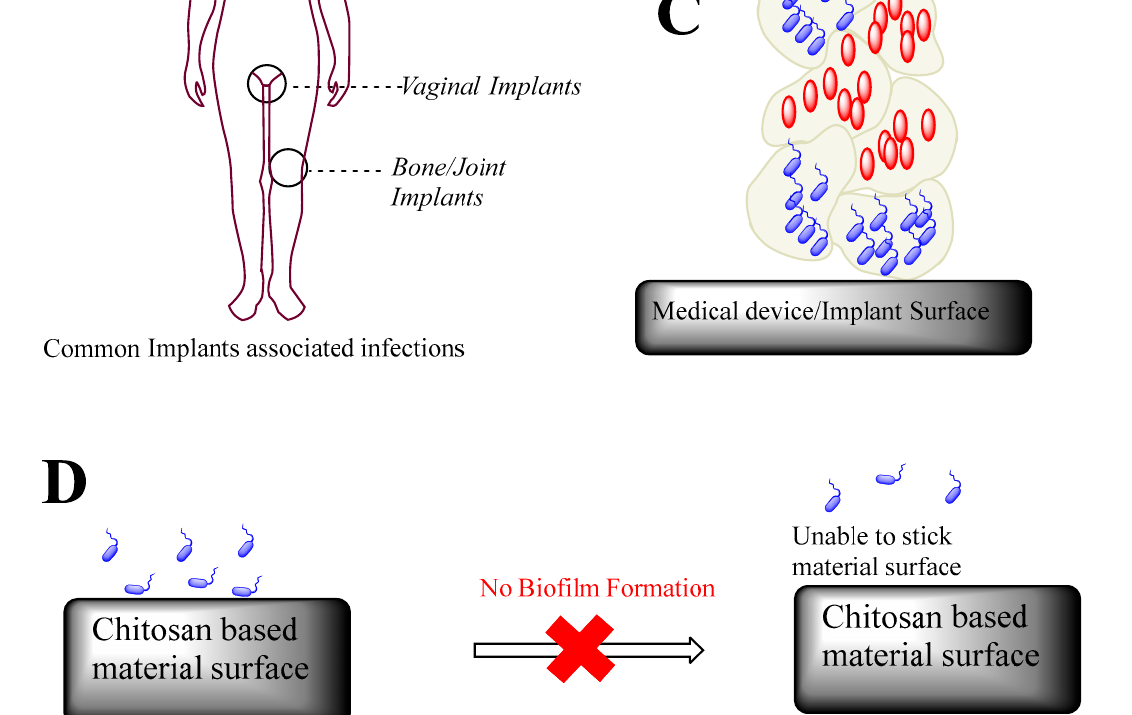
Figure 2. ( A ) Formation of microbial biofilm on the surface of implants. ( B ) Various human implants for biomedical use. ( C ) Biofilm formation on implant surface showing different microbial colonies. ( D ) Application of chitosan-based material surfaces to prevent microbial biofilm formation [11].